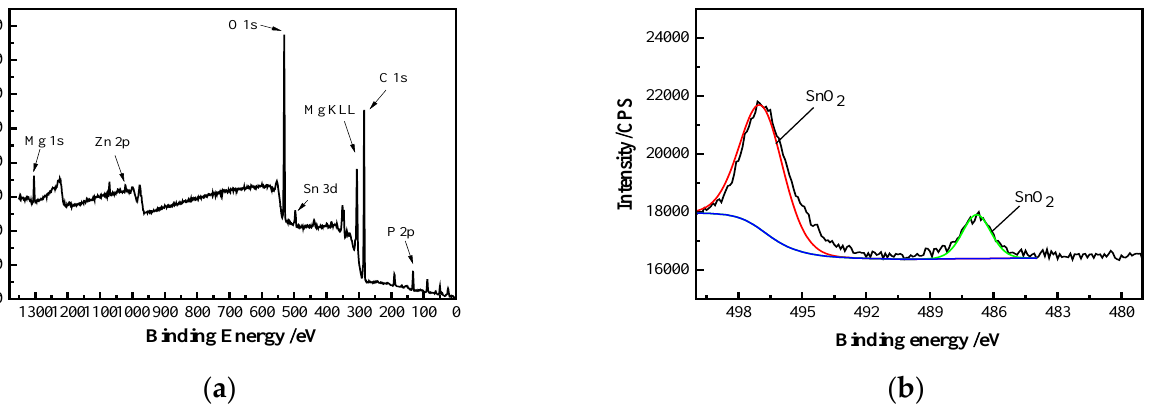
Figure 7. XPS survey spectra ( a ) and detailed spectra of Sn 3d ( b ) of corrosion products for Mg-1Zn- 1.0Sn after immersion in PBS at 37 °C for 1 h.